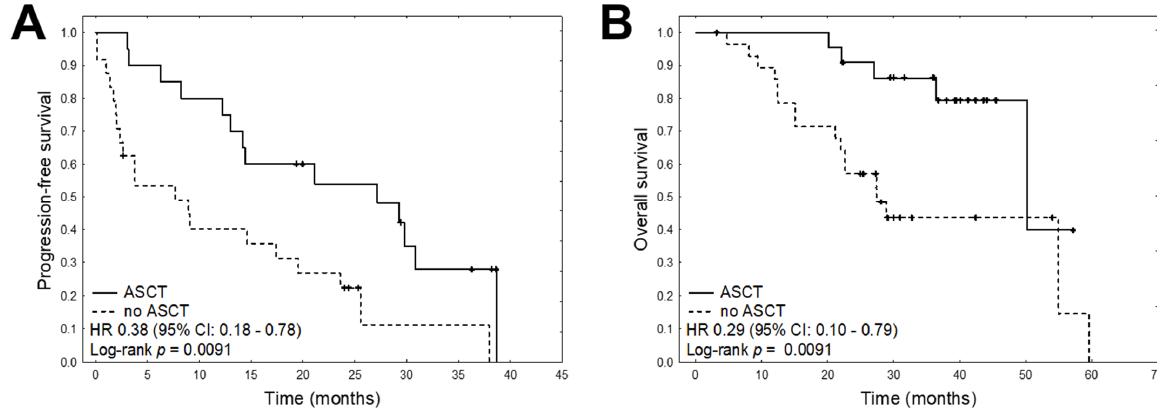
Figure 5. Kaplan–Meier plots for ASCT in the univariate analyses for ( A ) PFS and ( B ) OS.